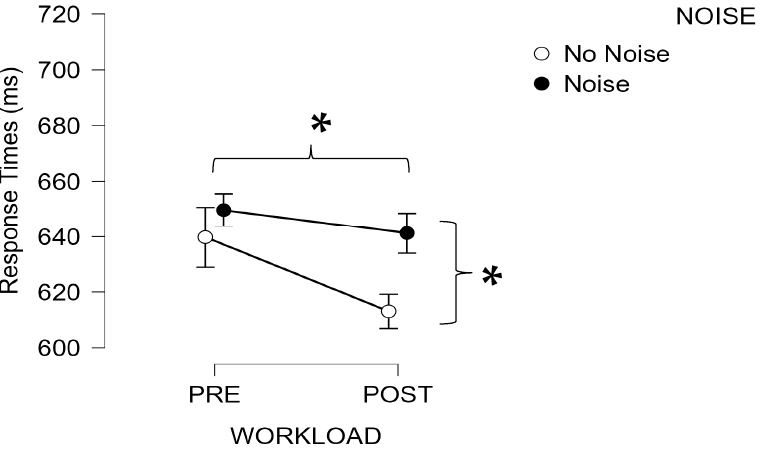
Figure 3. Response times (ms) of simple response time (SRT) and choice response time (CRT) tasks combined, without (No Noise) and with noise (Noise), before (PRE) and after (POST) the workload. * represents significant difference at p < 0.05, and bars represent standard errors. Table 1. Noise × Workload × Task Repeated Measures ANOVA